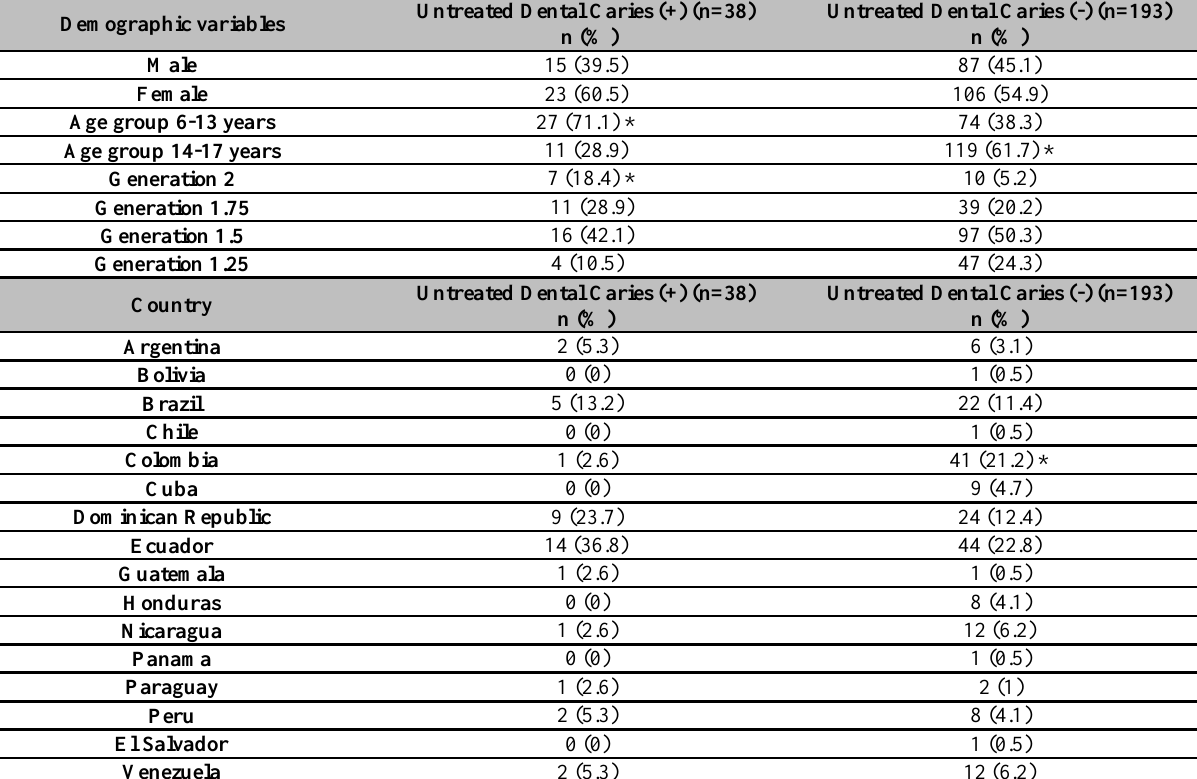
Table 3. Comparison of the prevalence of untreated dental caries with the demographic variables and countries of origin of 231 Latin American children in the child protection system of Aragon